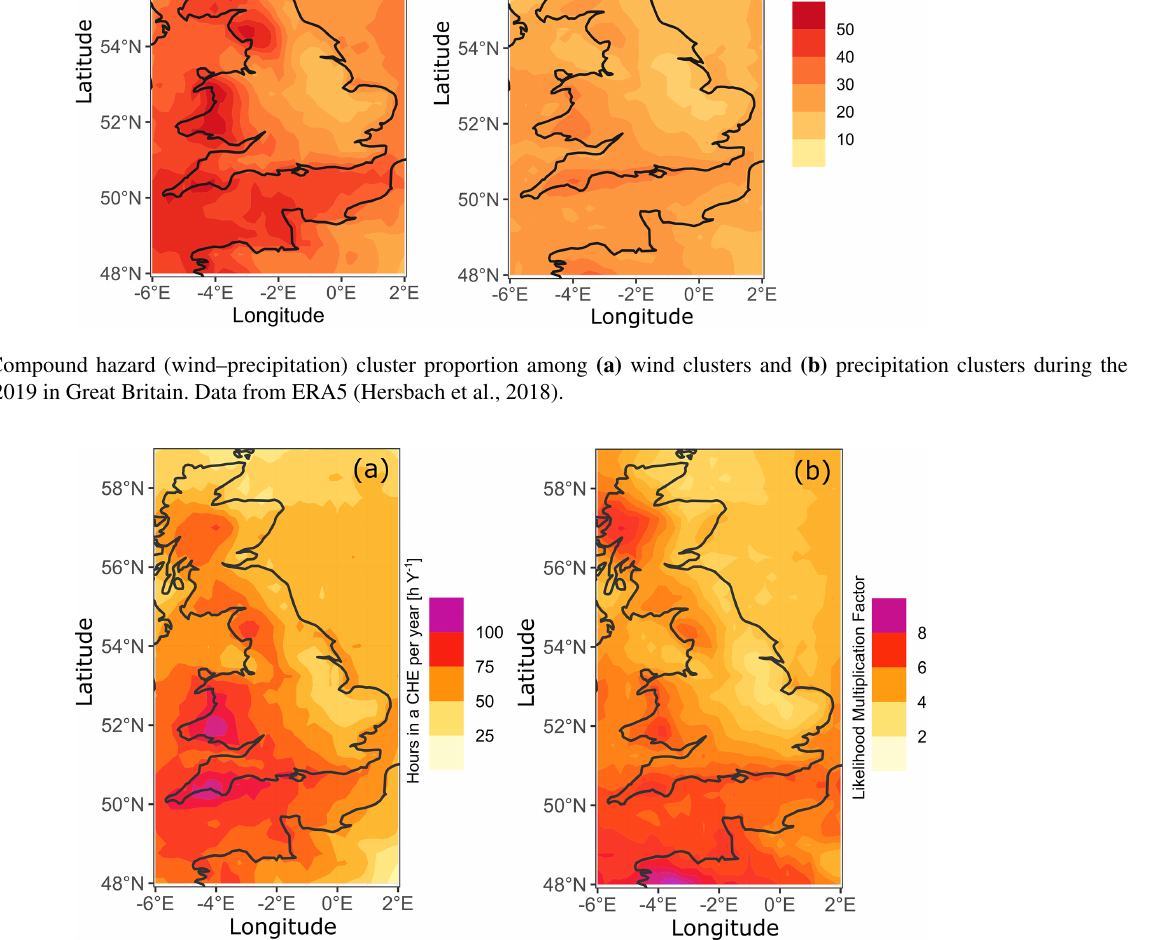
Figure A3. Hotspots for compound wind–precipitation clusters in Great Britain showing (a) the average number of hours in a compound hazard cluster in a year for 1979–2019 and (b) the likelihood multiplication factor (LMF) that quantifies the influence of the dependence between wind and rain clusters on the estimation of the probability of occurrence of compound hazard clusters. Data from ERA5 (Hersbach et al.,